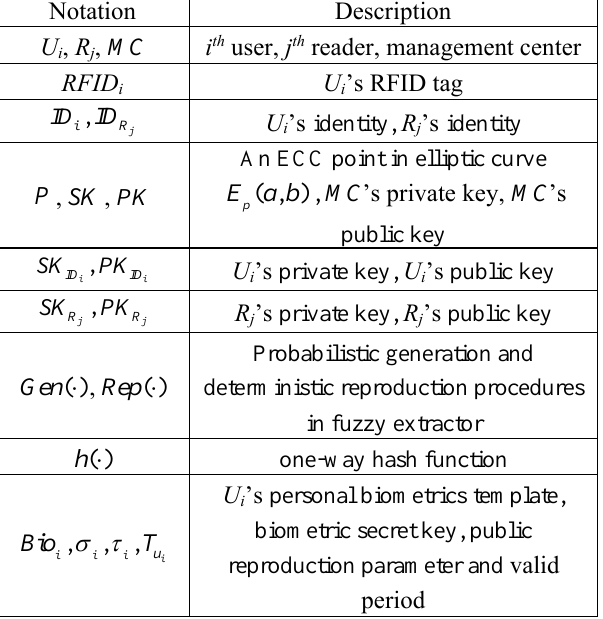
Table 1. Notations of